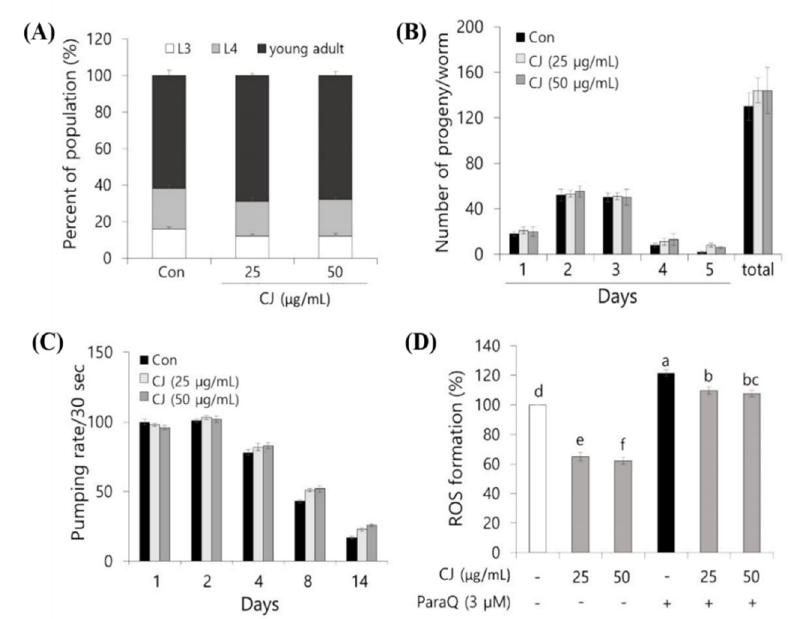
Figure 4. The e ff ect of CJ extract on the growth factors and protective e ff ect against oxidative stress of C. elegans . CJ extracts (25 and 50 µ g / mL) does not change normal growth factors: ( A ) population, ( B ) progeny production. ( C ) CJ extracts (25 and 50 µ g / mL) delayed the age-related behavioral symptom: pumping speed. Since the L1 stage, the nematodes were treated with 25 and 50 µ g / mL CJ extracts for measuring normal growth factors and pumping speed. Each value represents mean ± standard error (n = 3 plates and 100 worms / plate for growth rate; n = 3 plates and five worms / plate for progeny production; n = 3 plates and 15 worms / plate for pumping rate) ( D ) CJ extracts (25 and 50 µ g / mL) lowered ROS generation in C. elegans . Each bar represents the mean ± SD of three individual experimental results (n = 3). Letters above bars indicate significant di ff erences according to Duncan’s multiple range test ( p < 0.05 ).